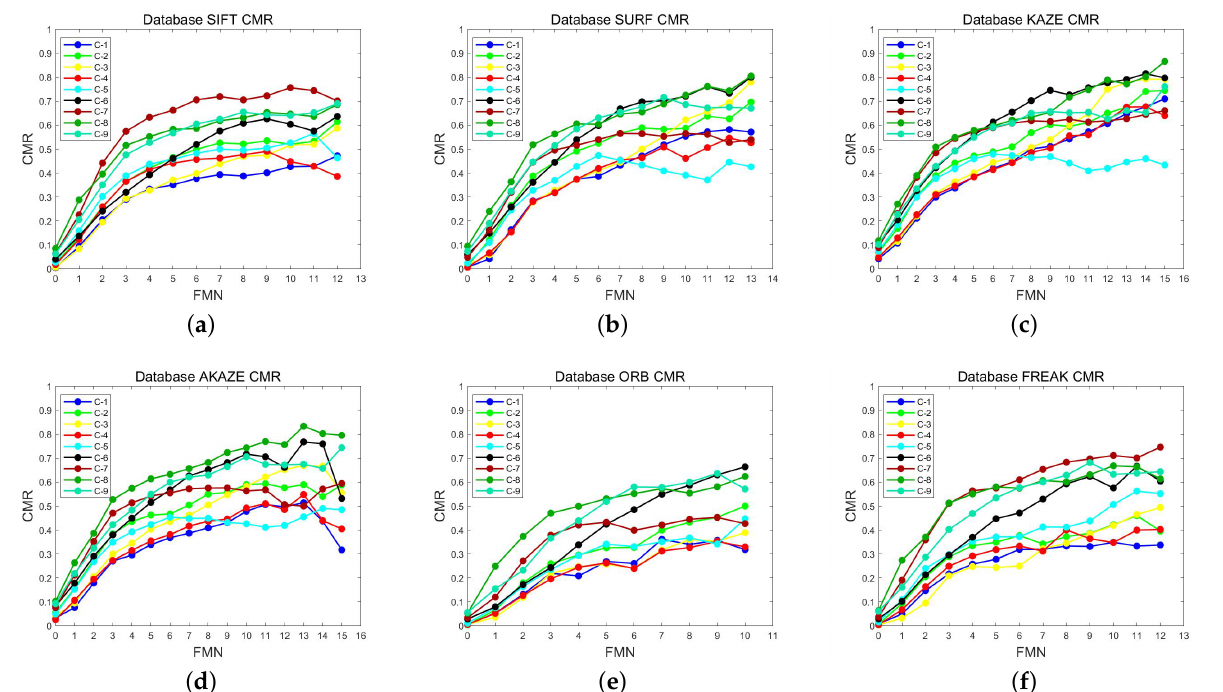
Figure 4. CMR of different FMN based on different feature database. ( a ) SIFT. ( b ) SURF. ( c ) KAZE. ( d ) AKAZE. ( e ) ORB. ( f )